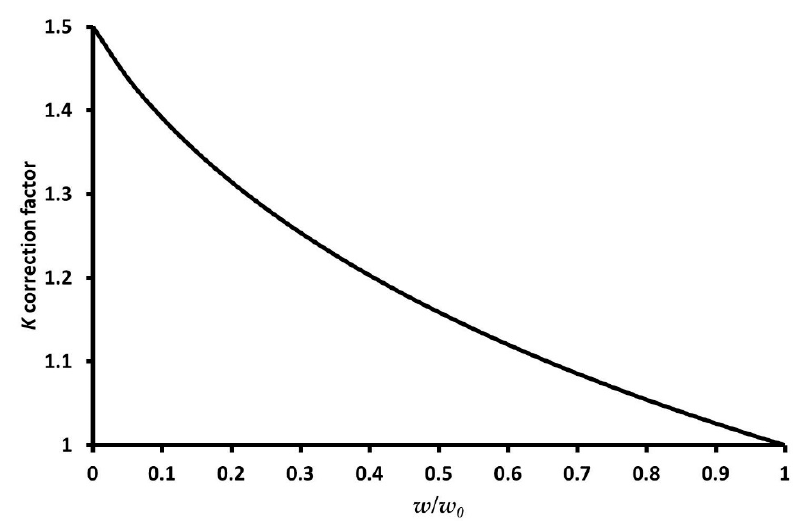
Figure 2. A calibration curve for trapezoidal plan-view cantilevers. The correction factor, K, can be determined from the w / w 0 , and then substituted into Equation (7) to determine the cantilever spring constant. Appl. Sci. 2019 , 9 , x